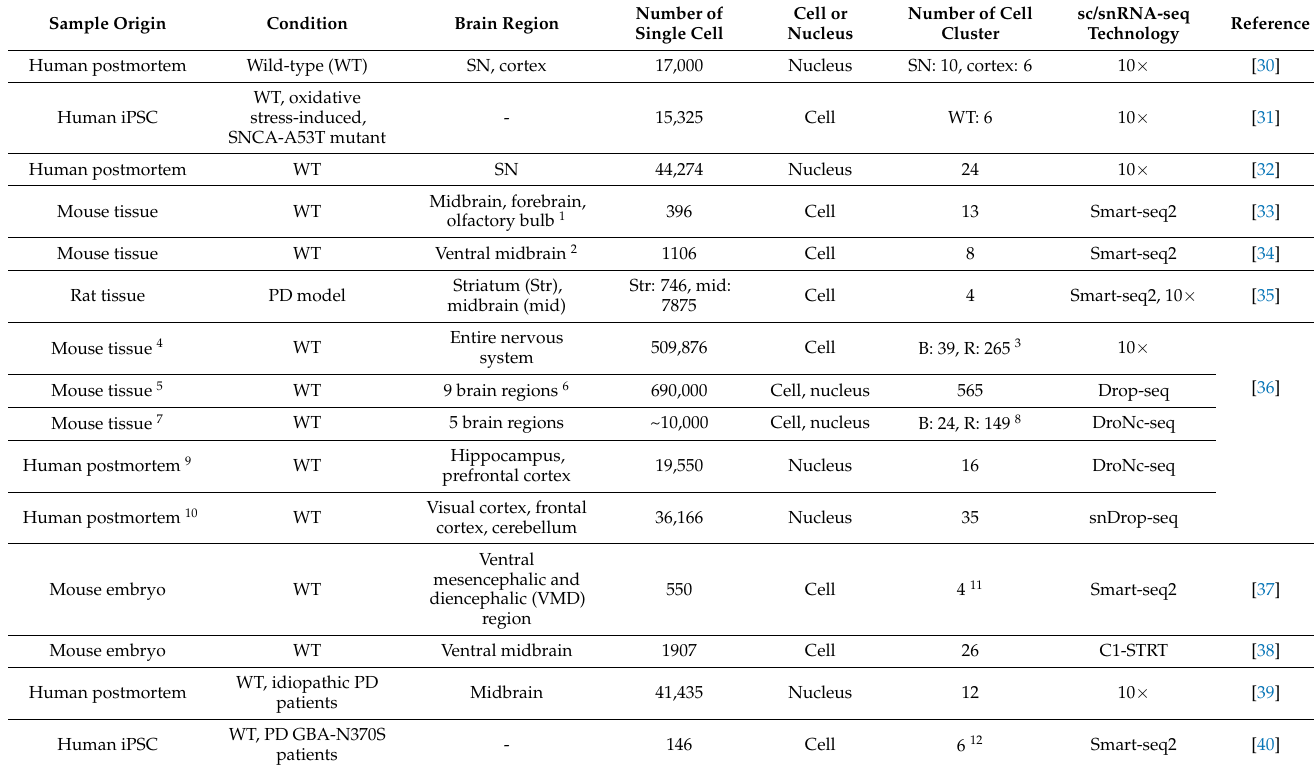
Table 1. Summary of single-cell and single-nucleus RNA sequencing (sc/snRNA-seq) datasets analyzed in studies of Parkinson’s disease (PD) and in those of dopaminergic neuron (DaN) neurogenesis. Sample